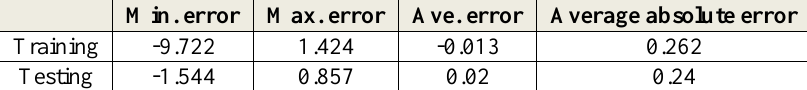
Table 12. Selecting the best network structure for prediction